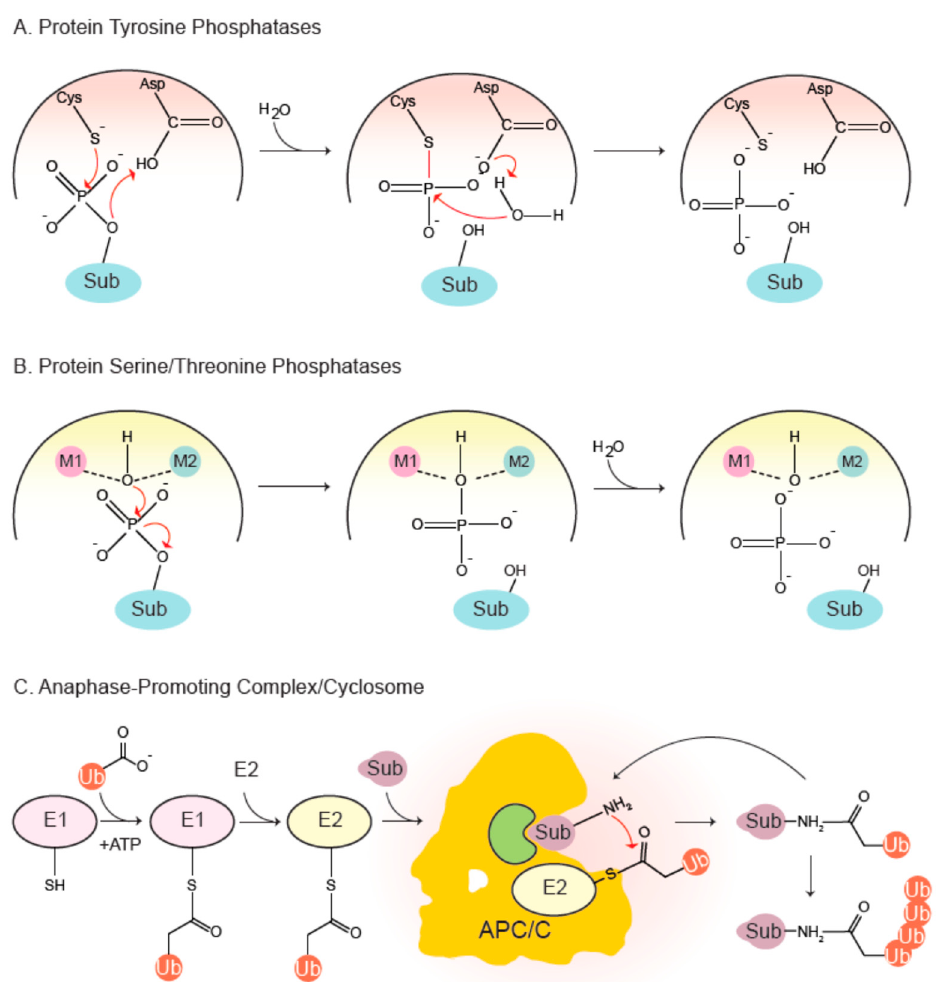
Figure 2. Catalytic mechanisms of protein tyrosine phosphatase (PTP), protein serine/threonine phosphatase (PSP) and anaphase-promoting complex/cyclosome (APC/C). ( A ) PTP; the sulphur atom of the catalytic cysteine, part of the signature PTP loop sequence, initiates a nucleophilic attack on the phosphoryl group of the substrate and forms a phosphoryl-enzyme intermediate, while the dephosphorylated substrate receives a proton from the aspartate residue that forms part of the WPD loop. A water molecule leads to hydrolysis of the phosphoryl group. ( B ) PSP; enzyme-bound two metal ions (e.g., Fe 2+ , Zn 2+ or Mn 2+ ) coordinate a water molecule that mounts a nucleophilic attack on the substrate phosphoryl group, leading to substrate dephosphorylation. ( C ) APC/C E3 ubiquitin ligase; ubiquitylation requires the action of three enzymes (E1, E2 and E3). First, the E1 ubiquitin-activating enzyme uses ATP and catalyzes ubiquitin C-terminal adenylation. Then, an active site cysteine on the E1 enzyme attacks the C-terminus of ubiquitin and forms a thioester-linked E1~ubiquitin intermediate. The activated ubiquitin is then transferred to an active site cysteine of an E2 ubiquitin-conjugating enzyme. Finally, co-activator bound-APC/C (E3 ubiquitin ligase) simultaneously binds the ubiquitin-charged E2 and a substrate, leading to transfer of the ubiquitin molecule to a primary amine within the substrate. This process repeats several times, yielding polyubiquitylated substrate. Abbreviations: Sub, substrate.